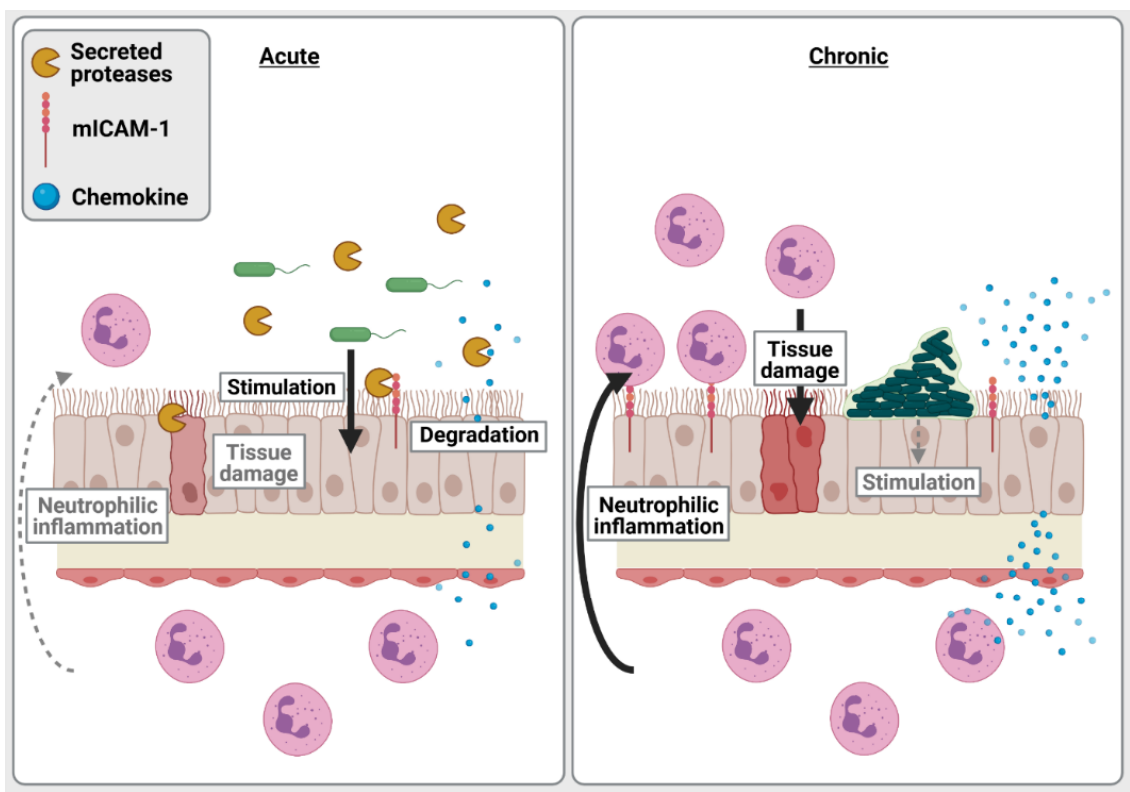
FIGURE 2: LasR-regulated proteases and neutrophilic inflammation in acute vs. chronic lung infection. In acute infection (left) such as in acute pneumonia, P. aeruginosa strains typically have a functional LasR system and express various extracellular virulence factors, leading to stimulation of the airway epithelium and immune cells to produce pro-inflammatory chemokines, cytokines and mediators such as mICAM- 1. LasR-regulated proteases degrade pro-inflammatory mediators thus following P. aeruginosa to evade host immunity, dampen neutro- philic responses while causing direct damage to host cellular barriers and extracellular matrix. In chronic infections (right) such as CF lung infections, P. aeruginosa growing as biofilms is typically non-motile, is more likely to harbour loss of function lasR variants and be protease- deficient. While P. aeruginosa may be attenuated in its production of acute virulence factors, it still favours a pro-inflammatory milieu due to a lack of proteolytic degradation of host cytokines and mediators by LasR-regulated proteases. This pro-inflammatory milieu leads to an exuberant neutrophilic response that is largely ineffective at clearing P. aeruginosa during chronic infections, but causes collateral tissue damage and lung